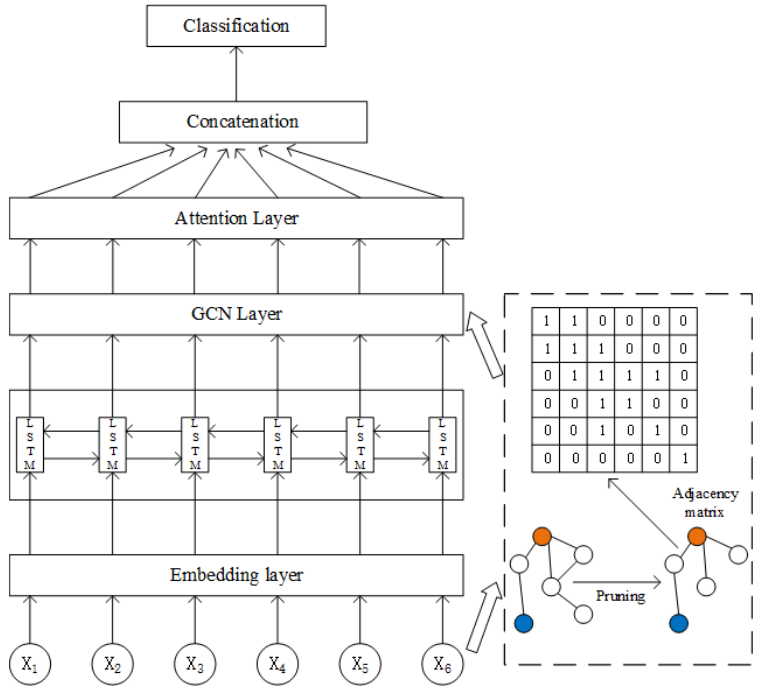
Figure 1. BAGCN model